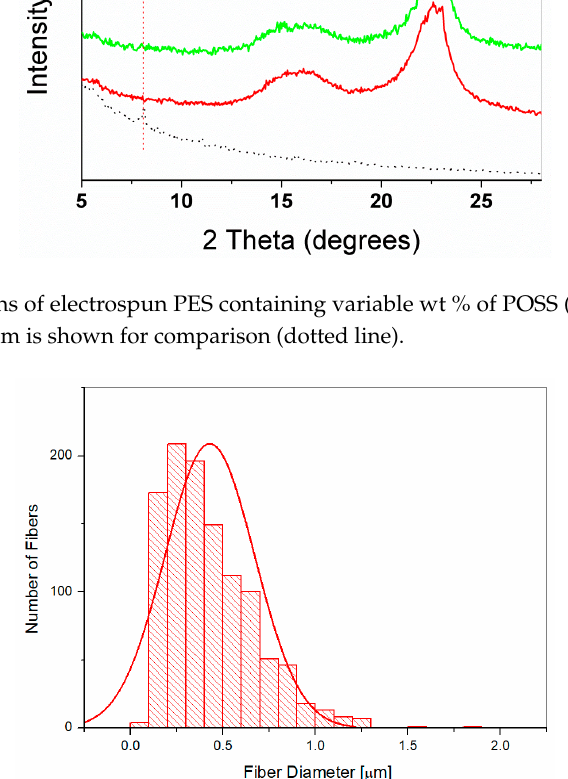
Figure 5. Histogram and Gaussian distribution of the fiber diameters for the veil with 10 wt % POSS